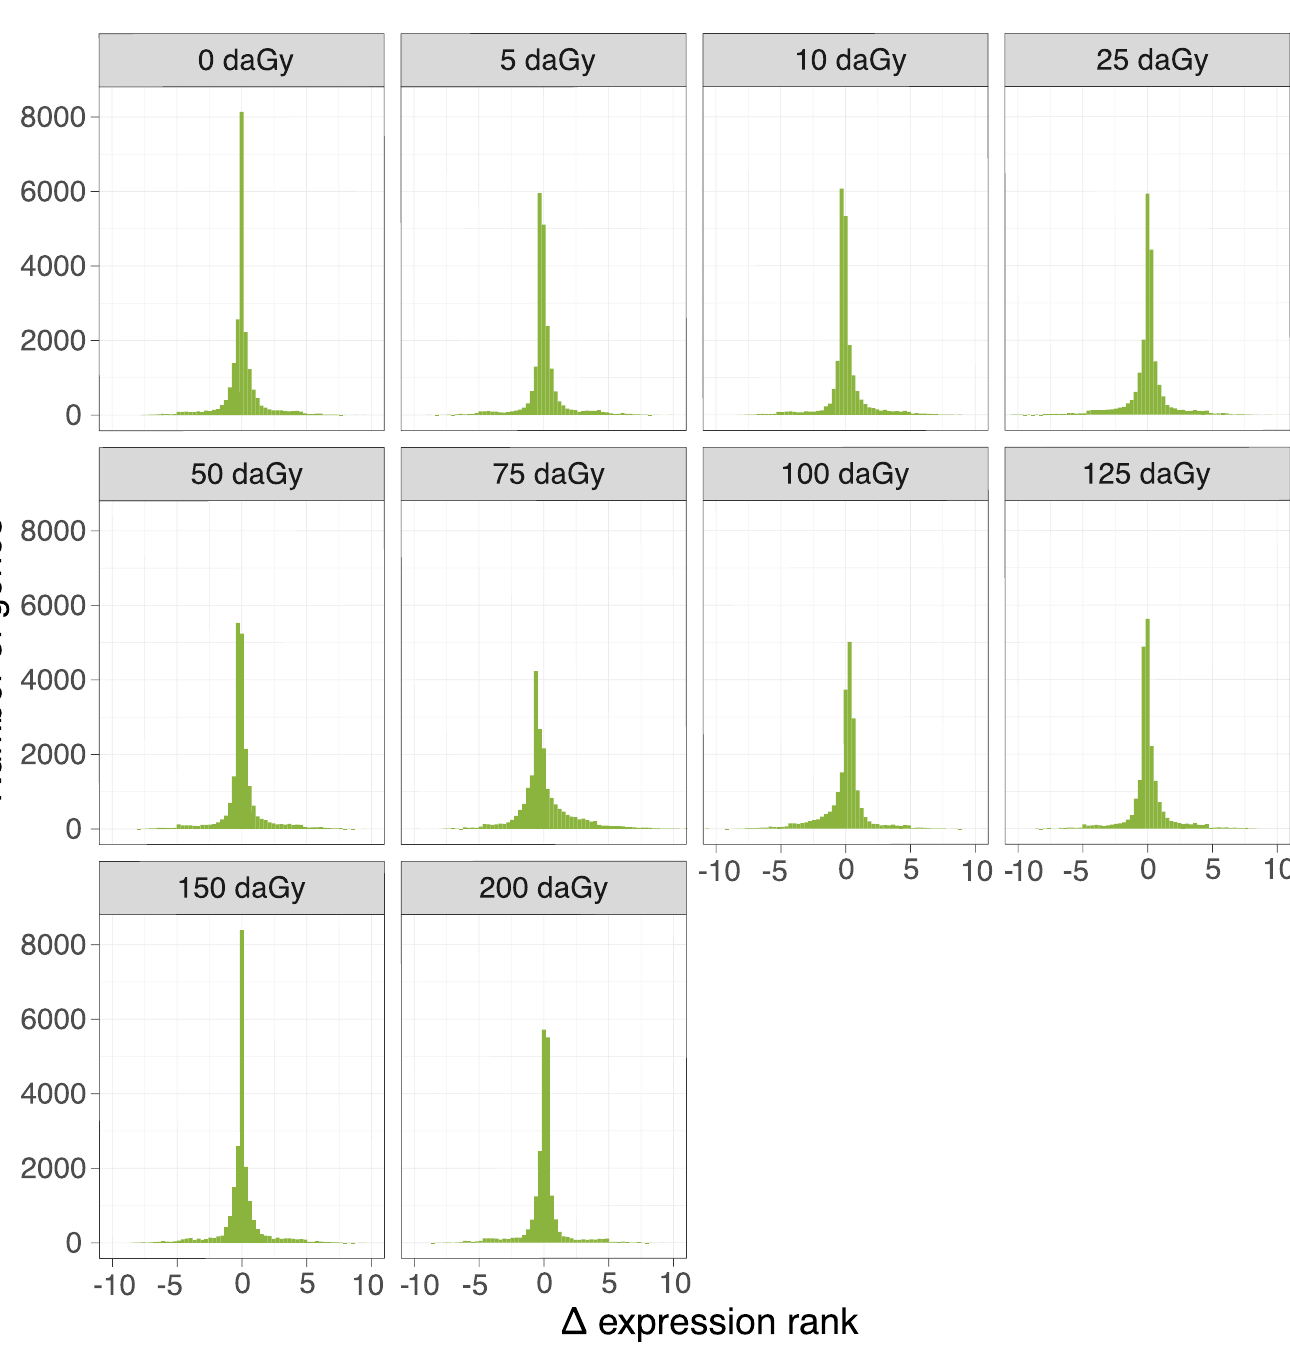
PLOS ONE | https://doi.org/10.1371/journal.pone.0207503 February 11,